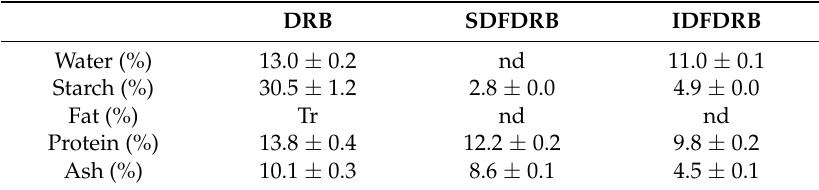
Table 5. Chemical composition of defatted rice bran and its dietary